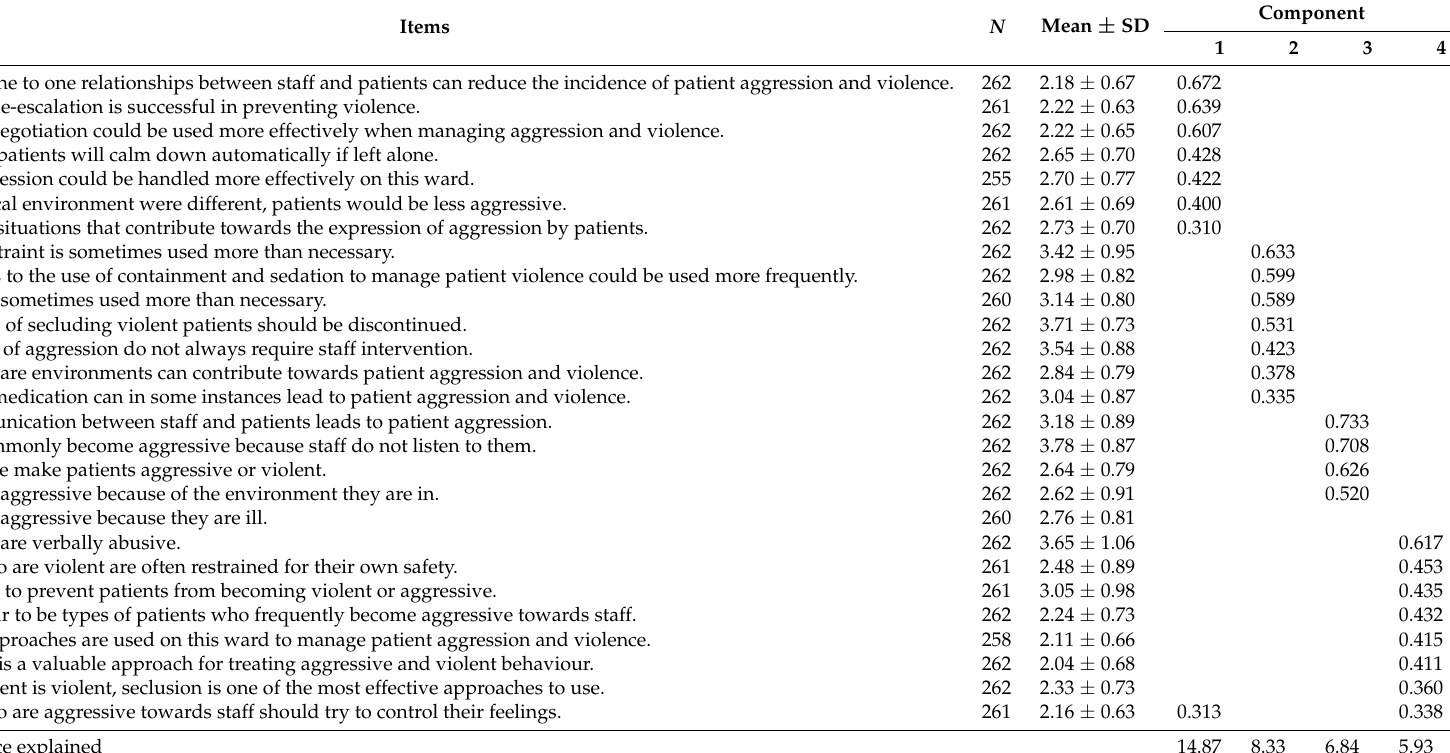
Table 3. Varimax rotation results of C_MAVAS and factor loading of the four-component factor analysis ( N = 262). Items N Mean ± SD Improved one to one relationships between staff and patients can reduce the incidence of patient aggression and